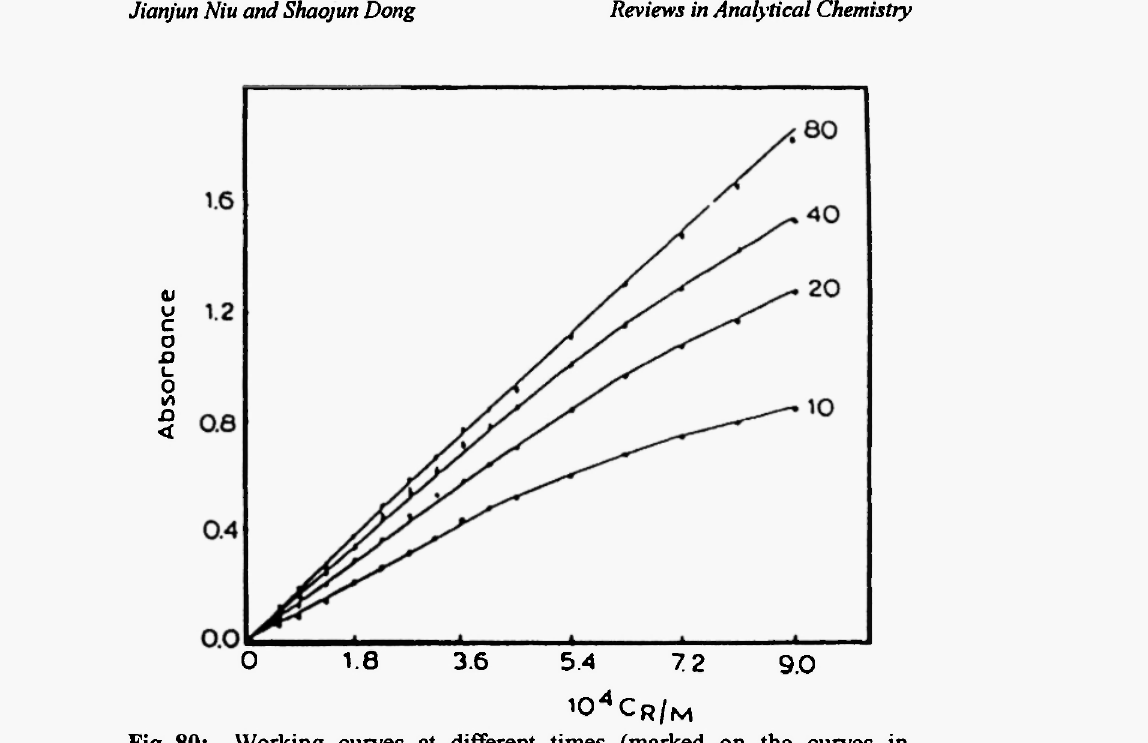
Fig. 80: Working curves at different times (marked on the curves in seconds) after the start of electrolysis. (From Ref.